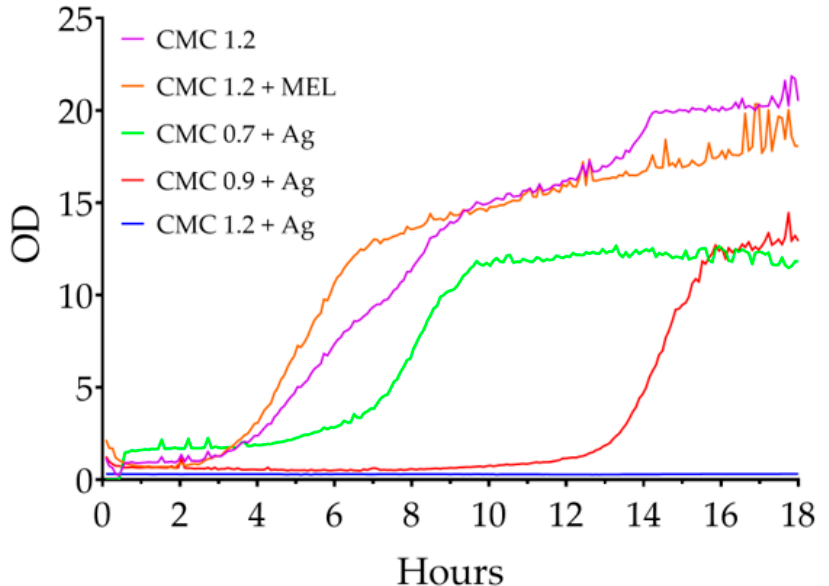
Figure 11. Changes in the optical density of liquid P. aeruginosa cultures in the presence of the films tested.